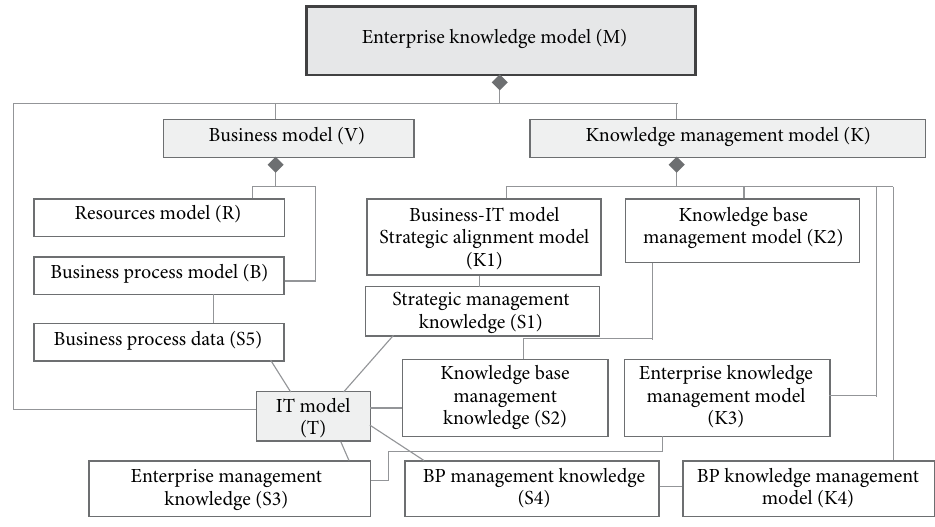
Fig. 4. The major knowledge subsets of the enterprise knowledge base (Gudas, Brundzaite